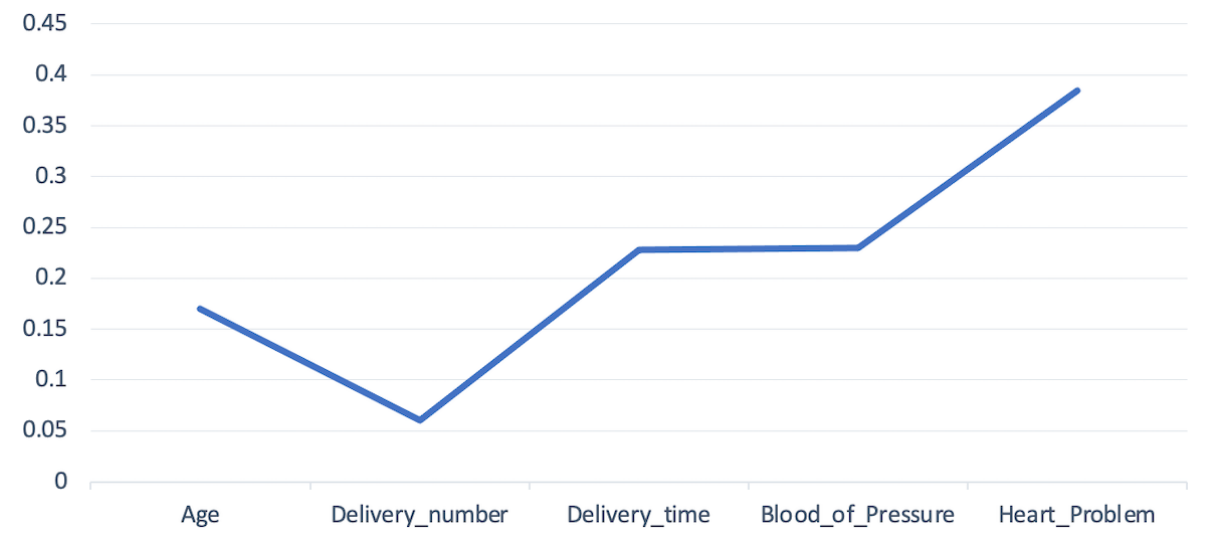
Figure 5. Correlation between attributes and